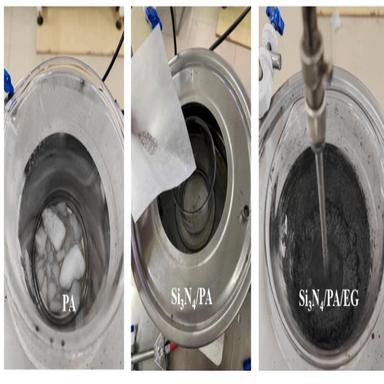
Schematic and actual pictures of the preparation of the CPCMs.